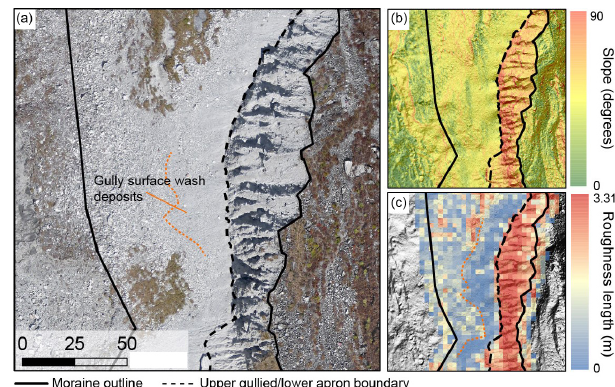
Figure 5. Moraine delineation method. The crest is often well de- fined by the orthomosaic (a) and slope (b) . An intermediate zone with gully surface wash deposition is clearly visible from the rough- ness data (c) . The moraine consists of an intensely gullied upper part (right) and a lower debris apron consisting of coalescing debris cones (left). See Fig. 2 for